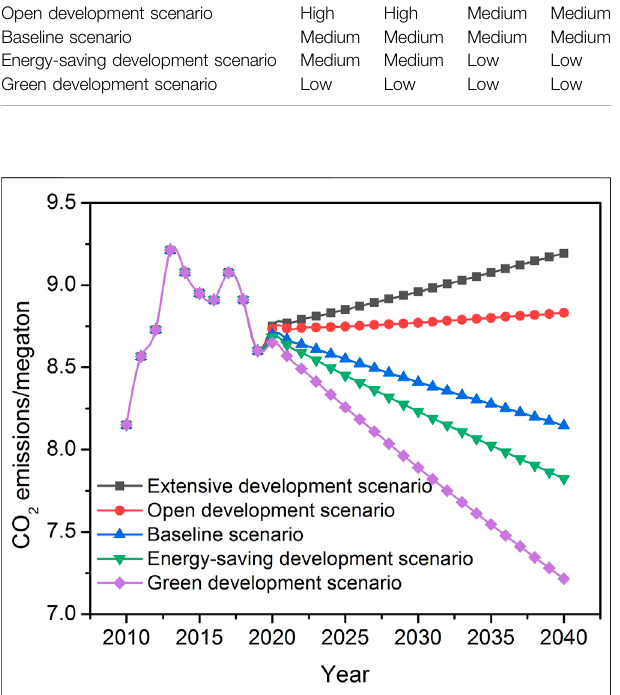
FIGURE 2 | Carbon emission forecast for each port in varied